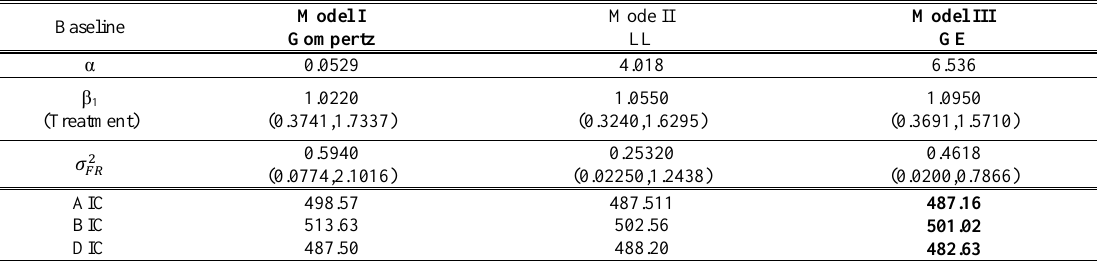
Table 4. Parameter estimates (credible intervals) of RATS dataset under the generalized gamma shared frailty